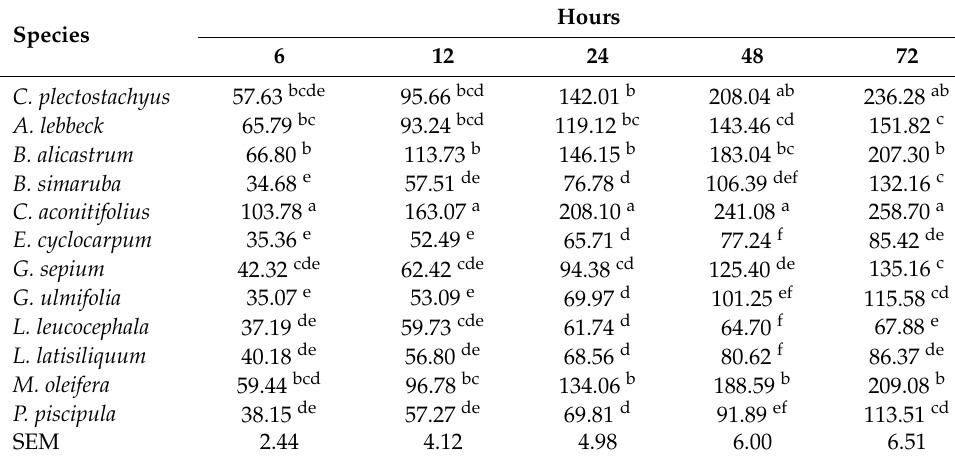
Table 3. Gas production (GP) of the foliage of tropical trees and shrubs at different in vitro ruminal fermentation times (mL/g